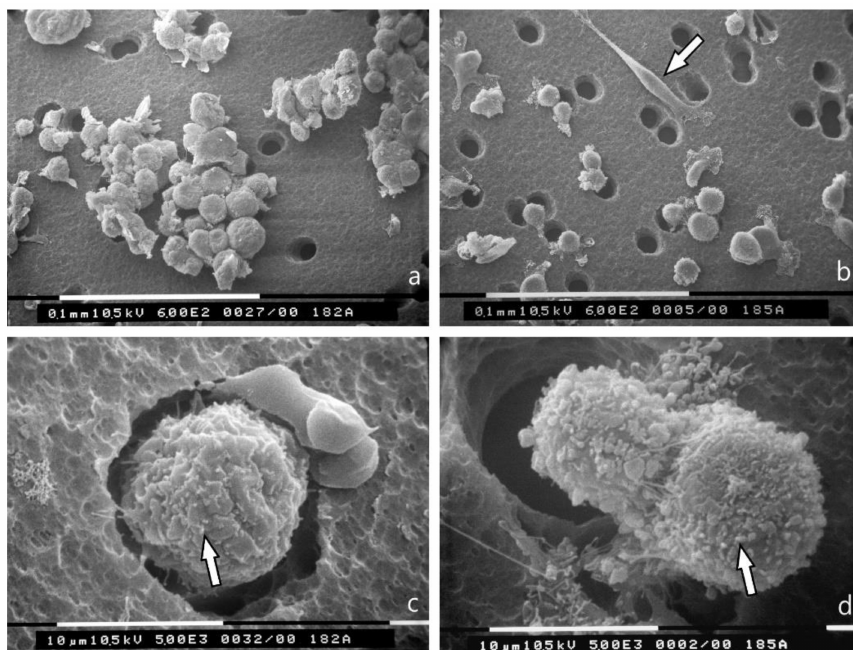
Figure 2. 3D Millipore filter cultures observed at SEM. ( a ) MCF-7 cells assemble around the holes of the Millipore filter with many cell-cell contacts and show a globular/spherical morphology with a diameter of about 10 µ m. Bar 100 µ m; ( b ) Most of the MDA-MB-231 cells have a globular/spherical shape with a mean diameter of 10 µ m and evident cytoplasmic microvesicles. An elongated and spindle-like cell (arrow) with very few microvilli and microvesicles is also visible. Bar 100 µ m; ( c ) A globular/spherical cell is passing through a hole of Millipore filter and exhibits few microvilli (arrow) but no microvesicles. Bar 10 µ m; ( d ) Two MDA-MB-231 globular cells with microvesicles (arrow) are crossing the holes of the Millipore filter. Bar 10 µ